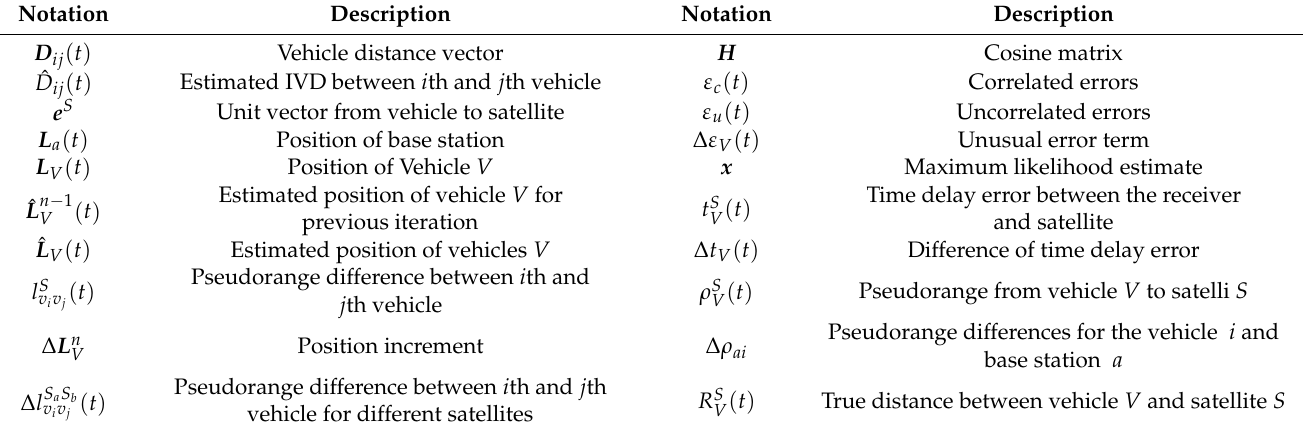
Table 1. Nomenclature used in this